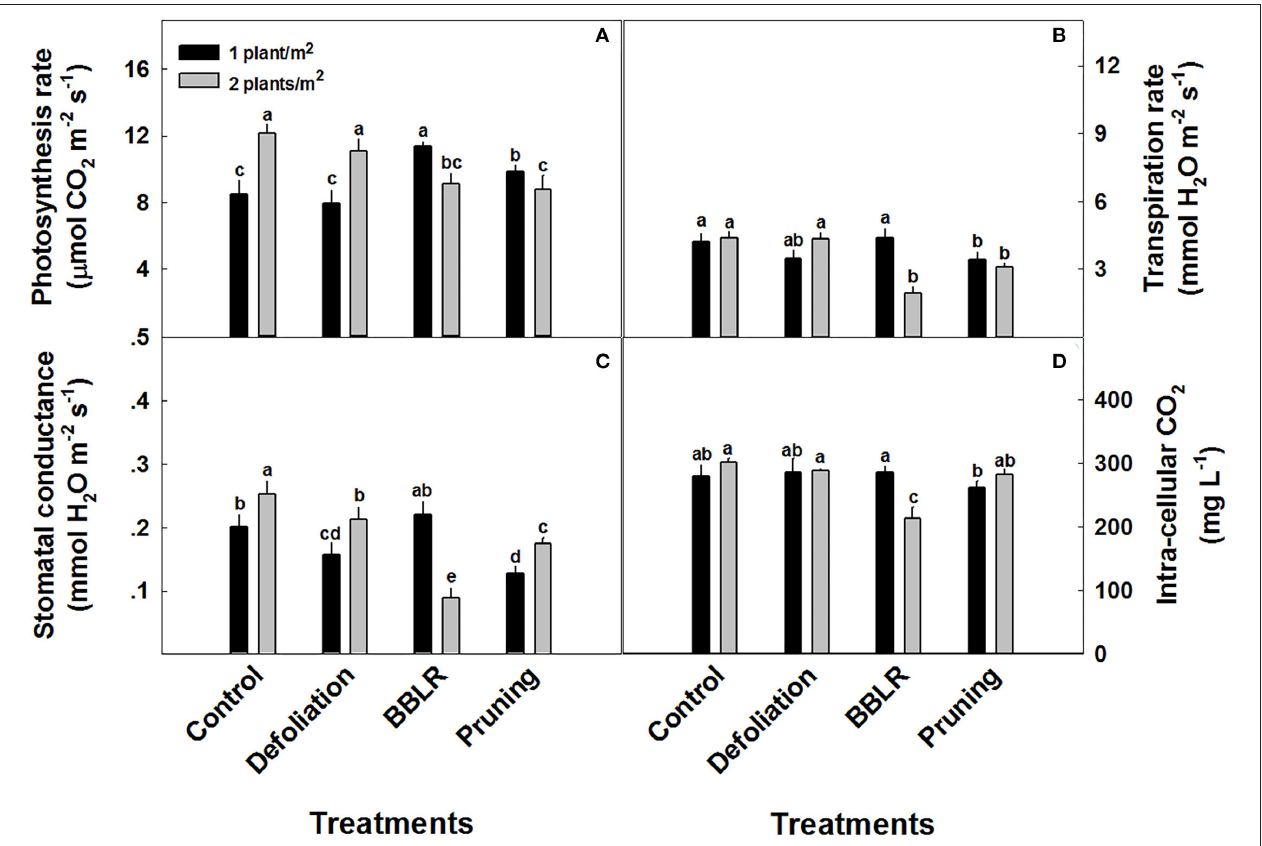
FIGURE 6 | Response of gas-exchange parameters to planting density (1 and 2 plants/m 2 ) and plant architecture treatments in medical cannabis plants. Photosynthesis (A) , Stomatal conductance (B) , Transpiration (C) , and intracellular CO 2 (D) . The results are mean and SE ( n = 6). Different letters above the bars represent significant differences between treatments by Tukey HSD test at α =